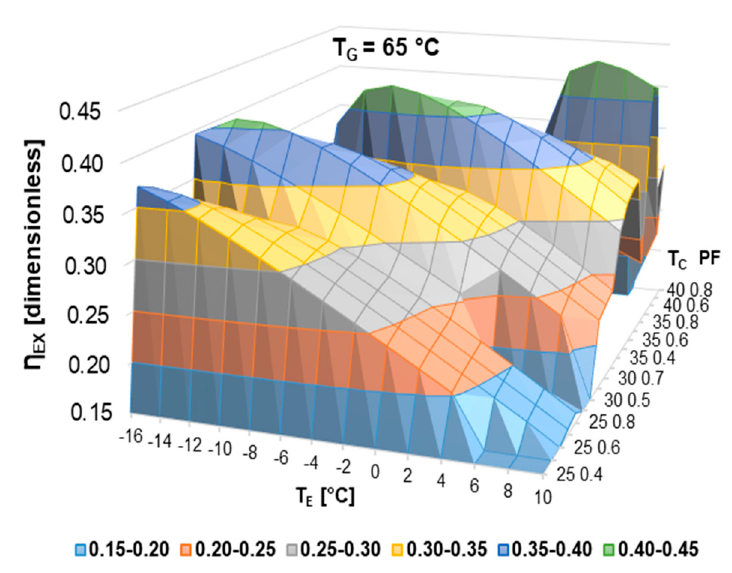
Figure 15. Exergy efficiency ( η Ex ) against T E and PF for different T C . Analyzed case: T G = 65 °C.